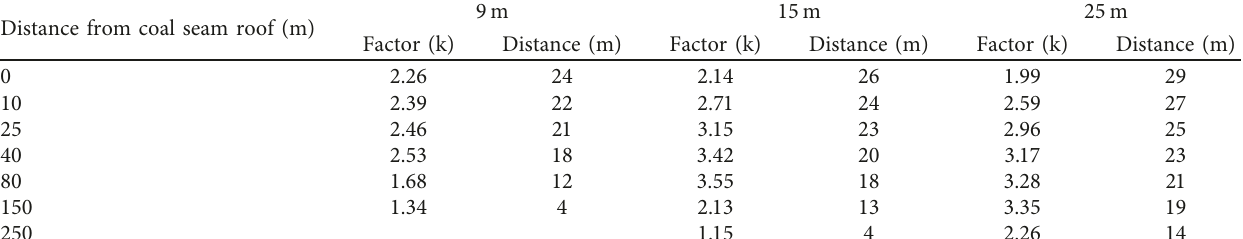
Table 3: Factor of stress concentration and the distance between peak stress and coal wall in different mining thicknesses. 9 Distance from coal seam roof (m)